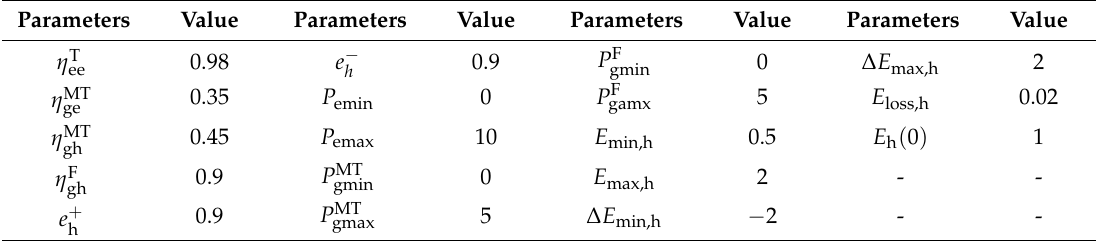
Table 2. Parameters for energy facilitator (pu).